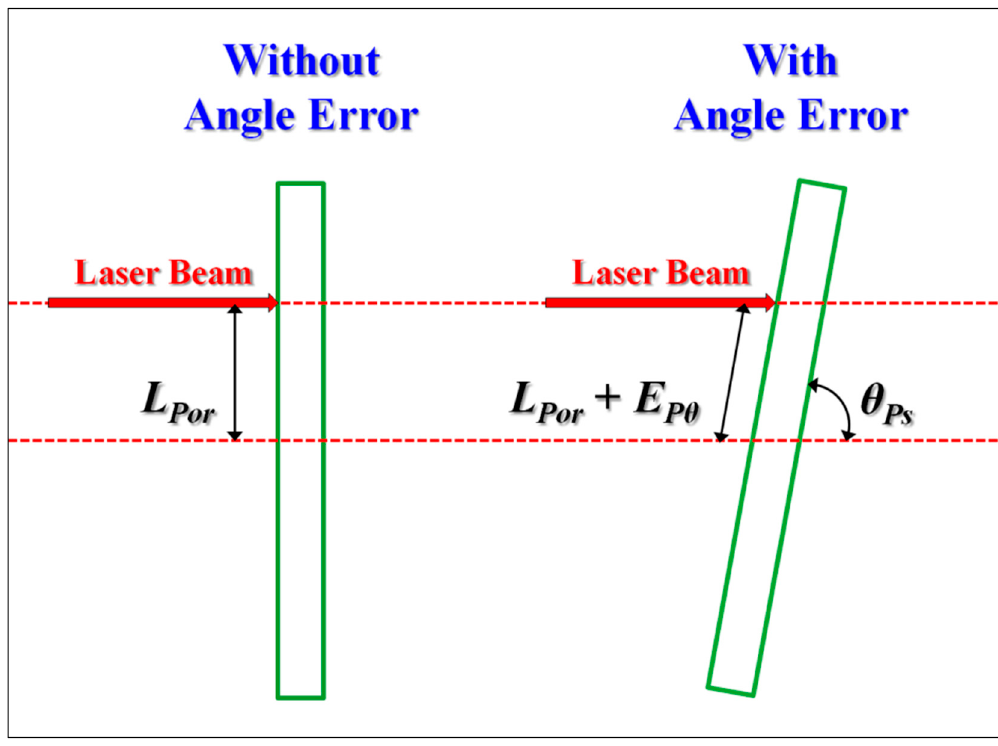
Figure 9. PSD setup error.